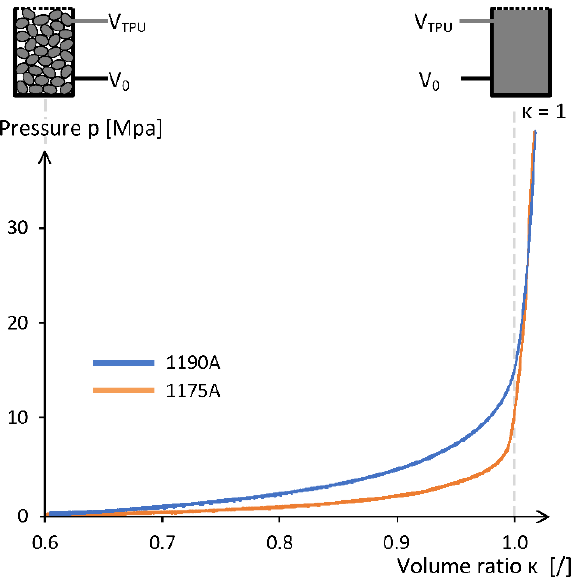
Figure 7. Level of prestress (pressure) with respect to volume ratio κ for both materials.